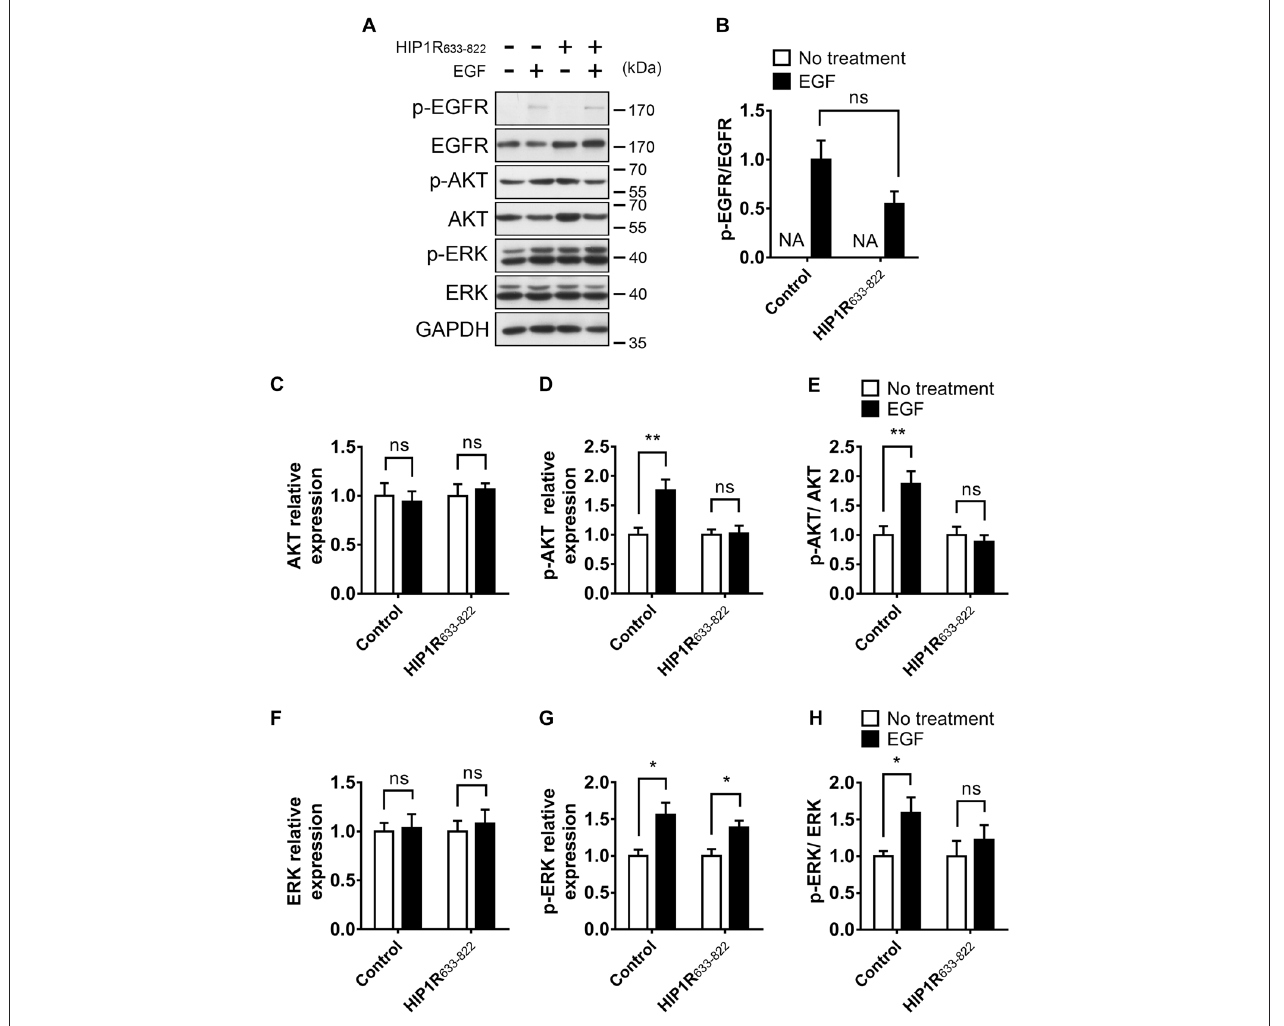
FIGURE 10 | Overexpression of HIP1R 633–822 attenuates EGFR downstream signaling. (A) EGFR, Akt and ERK expression and phosphorylation with or without EGF treatment, in DIV 12 neurons. (B) Quantitative analysis of phosphorylated EGFR level. NA, not applicable. (C–E) Quantification of Akt (C) , p-Akt (D) level and the p-Akt/Akt ratio (E) . Normalized by GAPDH and compared with untreated control. (F–H) Quantification of ERK (F) , p-ERK (G) level and the p-ERK/ERK ratio (H) . Normalized by GAPDH and compared with untreated control. Mean ± SEM; ns, not significant; ∗ p < 0.05; ∗∗ p < 0.01; n = 3 independent experiments; unpaired two-tailed t